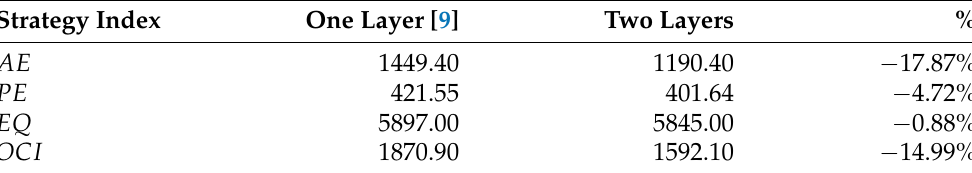
Table 5. Comparison of performance indices for one-layer and two-layer